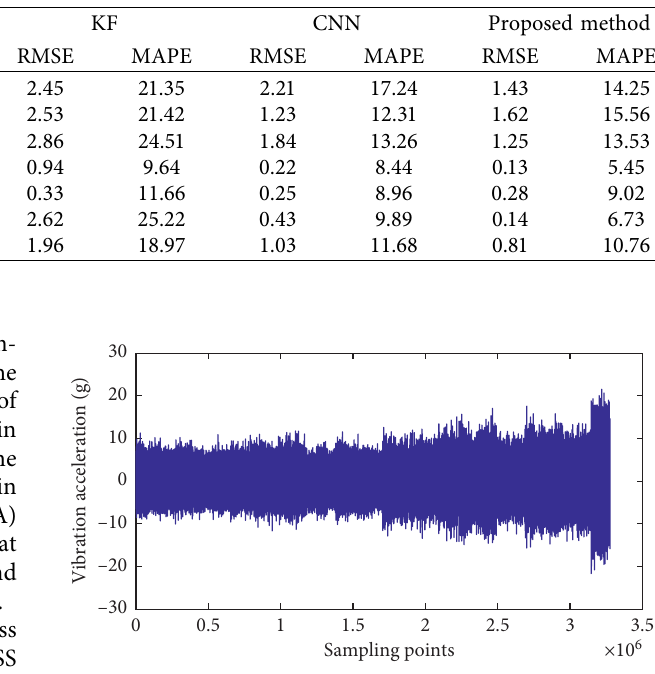
Figure 8: The time domain signal of the HSS